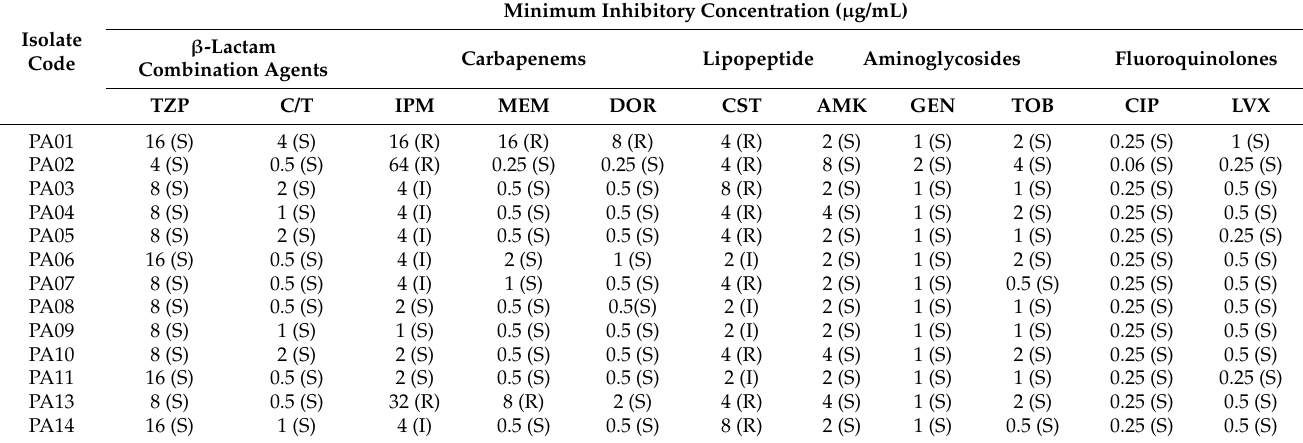
Table 1. Antimicrobial susceptibility in the colonizing isolates of P. aeruginosa .